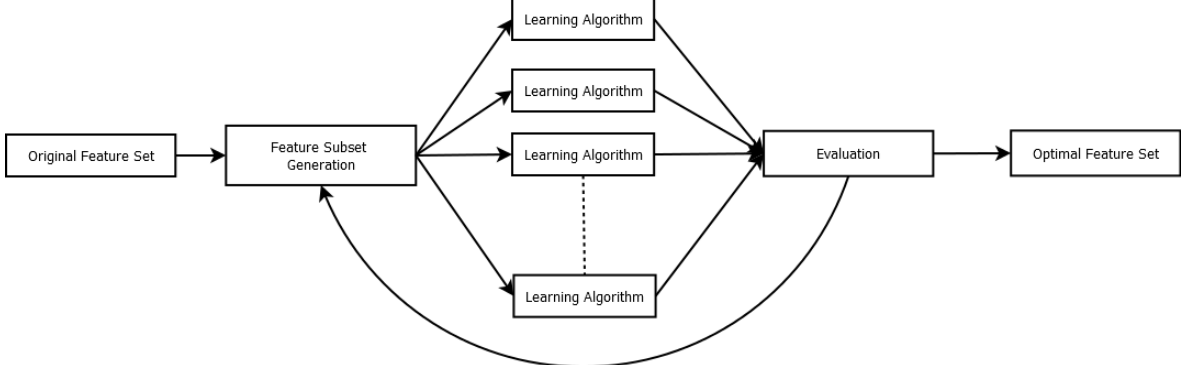
Figure 9. Proposed distributed model for feature selection.